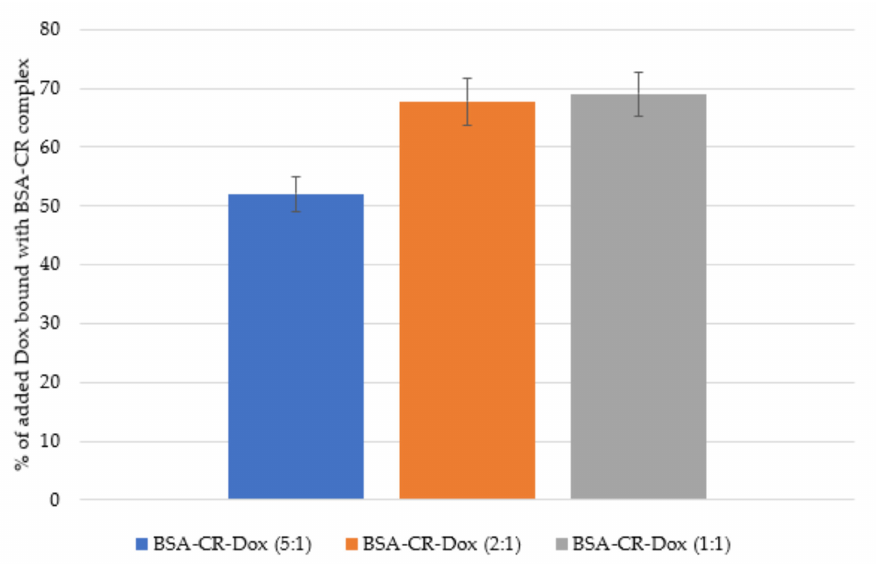
Figure 3. Percentage of added Dox bound with BSA–CR complex (mean ± SD, n = 3): for 5:1 molar ratio 52% ± 3%; for 2:1 molar ratio 67.8% ± 4.1%; for 1:1 molar ratio 69% ± 3.8%.